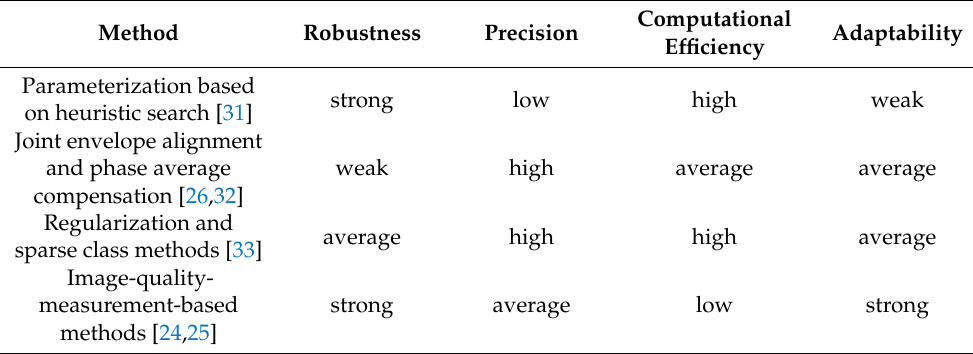
Table 1. Comparison of several popular motion compensation